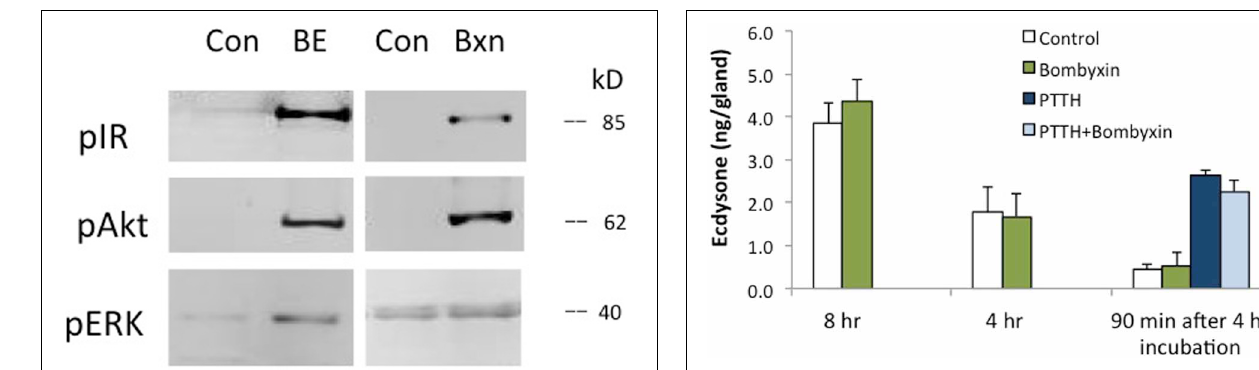
FIGURE 3 | Effects of Manduca brain extract and Bombyx bombyxin II on signaling phosphoproteins. Prothoracic glands from day 2 fifth instar larvae were incubated for 30min in Grace’s medium (Control), medium containing crude Manduca brain extract (BE, 0.5 brain equivalents/30ul) with both PTTH and insulin-like activities, or medium containing synthetic Bombyx bombyxin II (Bxn, 160nM). At the end of the incubation period cellular lysates were probed for phosphoproteins via Western blots.